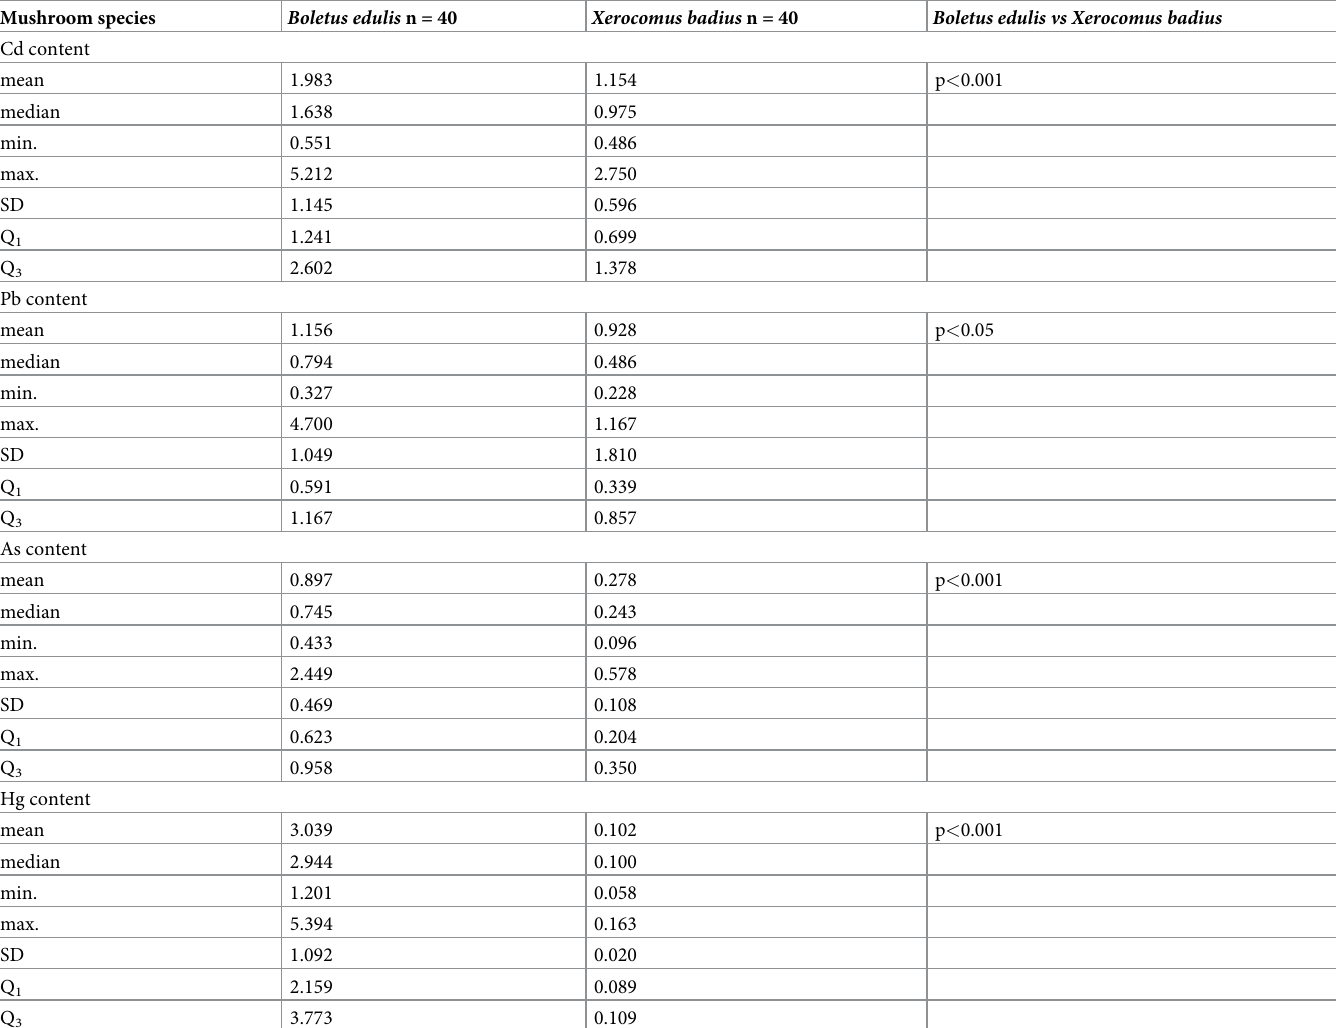
Table 3. Concentrations of Cd, Pb, As and Hg in dried mushrooms (mg/kg).